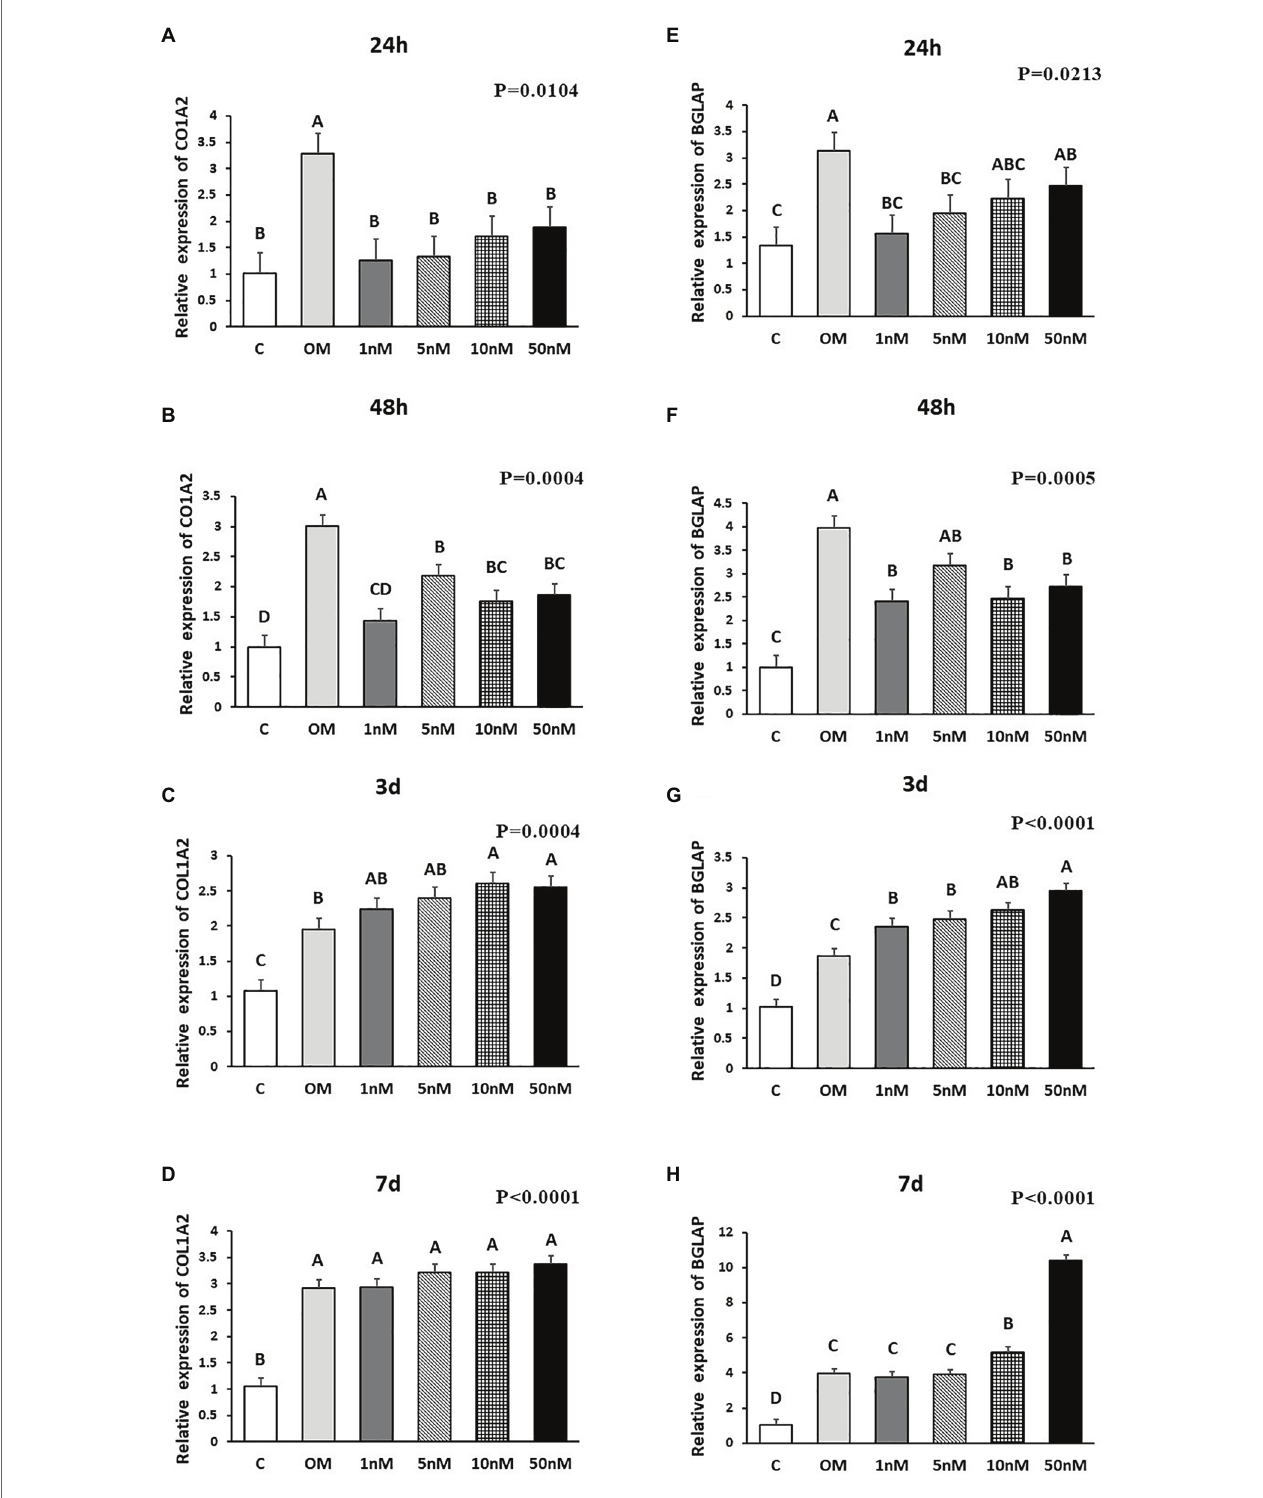
FIGURE 2 | Effects of 1,25OHD on chicken osteoblasts collagen type I alpha 2 chain (COL1A2) and bone gamma-carboxyglutamate protein (BGLAP) gene expression by using qRT-PCR. Cells were treated with control media, osteogenesis media, or osteogenesis media with 1, 5, 10, or 50 nM 1,25OHD. (A–D) showed the mRNA expression of COL1A2 at 24 and 48 h and 3 and 7 days, respectively; (E–H) showed the mRNA expression of BGLAP at 24 and 48 h and 3 and 7 days, respectively. (A–D) Mean separation was indicated by different letters on the top of bars (Value means ± SEM, three